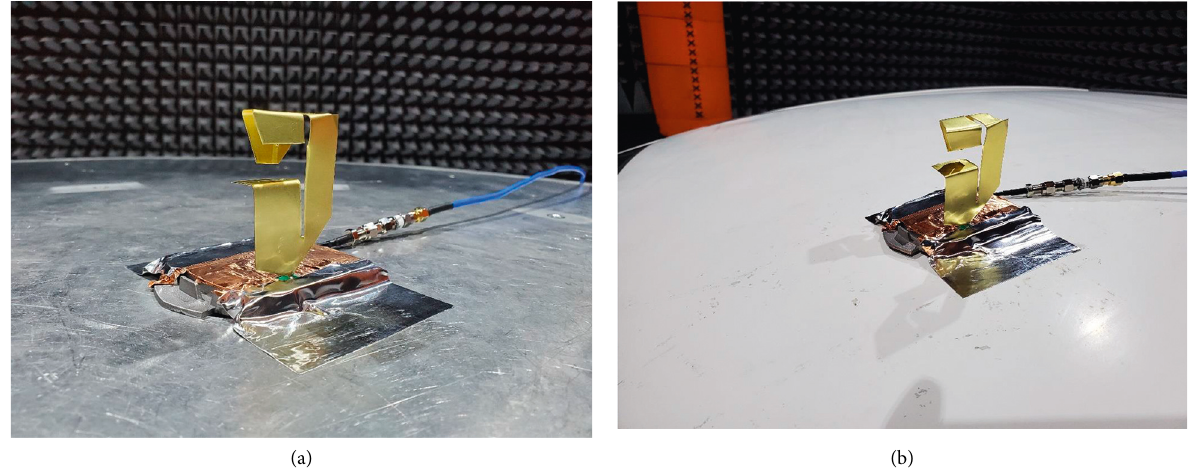
Figure 9: Fabricated antenna prototype. (a) On ground plane. (b) On vehicle’s roof.